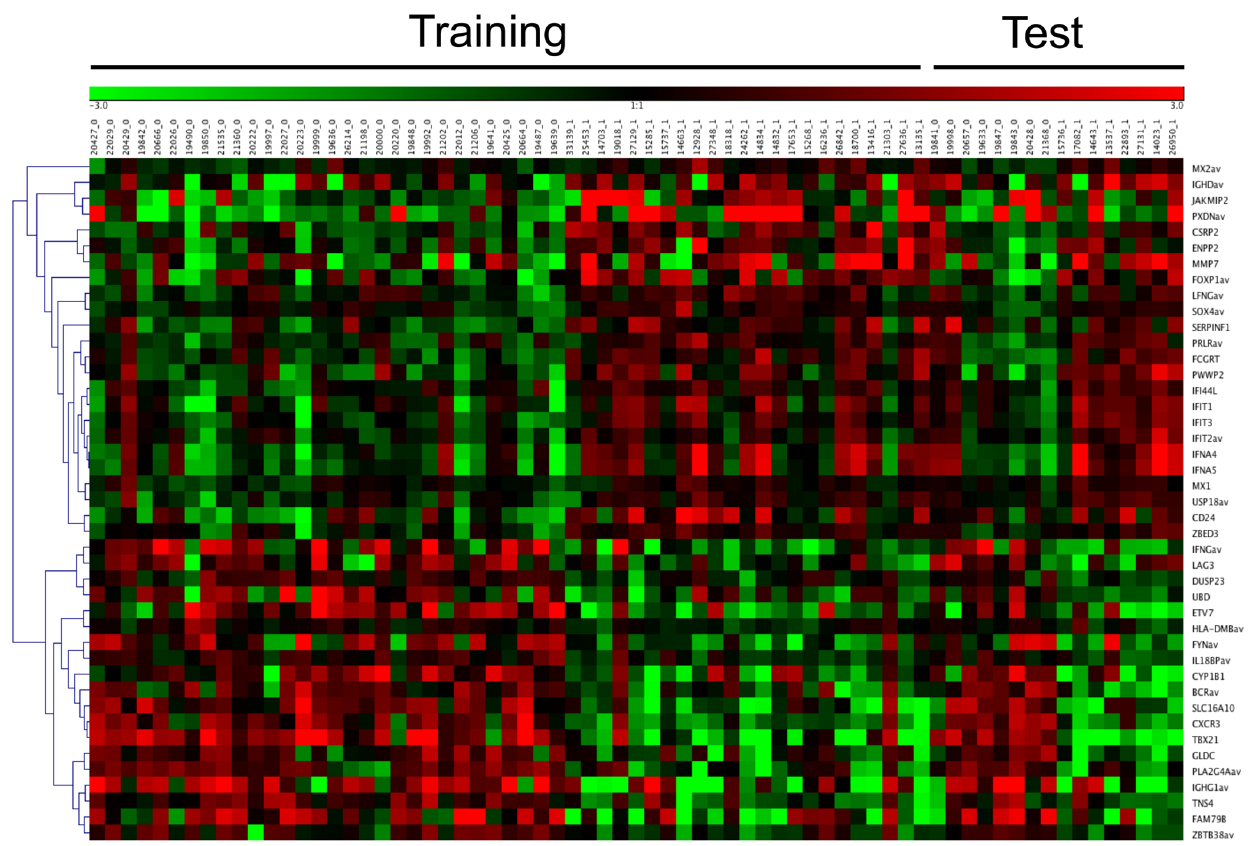
Figure 1. Heat map showing classification in training and test sets using the SC approach. Samples from the training set presented on the left (53) and those from the test set are presented to the right (16). BRCA1 status is indicated at the top of the heat map; BRCA1 + / 2 (0), BRCA 2 / 2 (1). Genes used in the predictor are listed at the right. These genes were sorted according to relatedness using the GENESIS program, and a dendrogram of relatedness is presented at the left of the figure. Samples that were mis-classified are indicated by arrows at the top of the figure. Misclassification arrows missing (as noted), remove red to green bar at top, colour code the samples to identify carriers and controls.